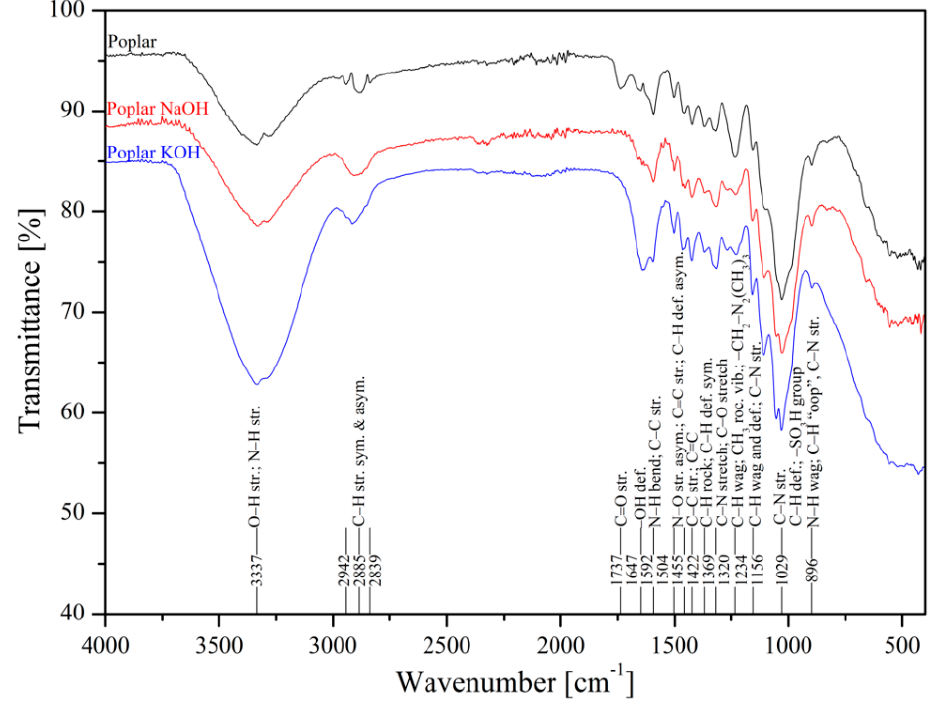
Figure 1. Infrared spectra of natural and treated poplar wooden sawdusts.